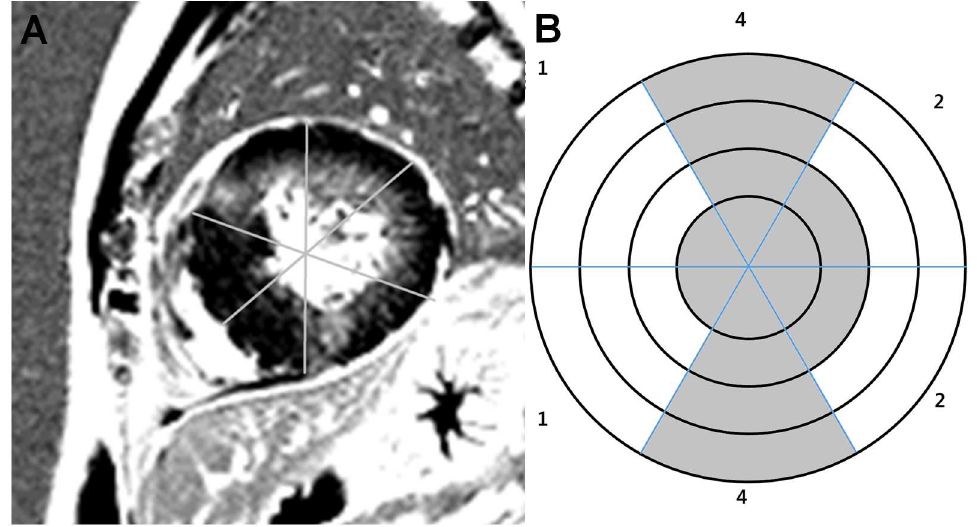
Fig 2. Example of sub-segmental scoring model used for visual coding of focal myocardial fibrosis location. a Cardiacmagneticresonance demonstrated extensive delayedcontrast enhancement in mid- ventricular short axis image. b Mid-ventricular segmentsare dividedinto four transmural zones and coded accordingto transmural extent of delayedcontrast enhancement.